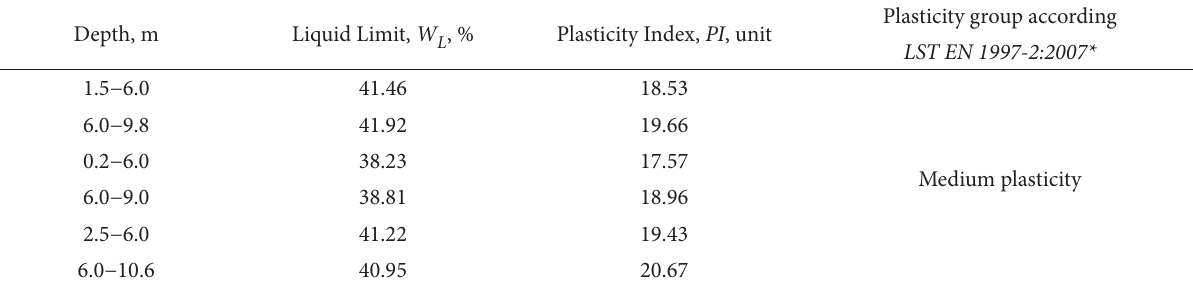
Table 2. Liquid Limit and Plasticity Index of Kuksa mine clay Depth, m